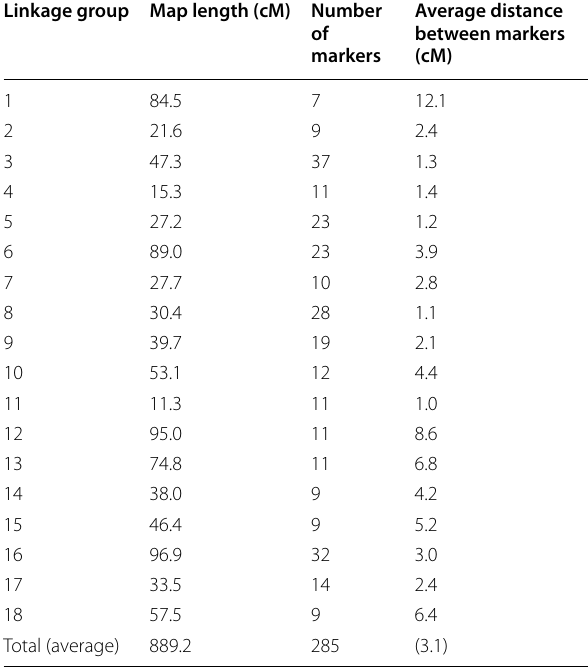
Table 1 Eruca vesicaria subsp. sativa draft linkage map statistics Linkage group Map length (cM) Number